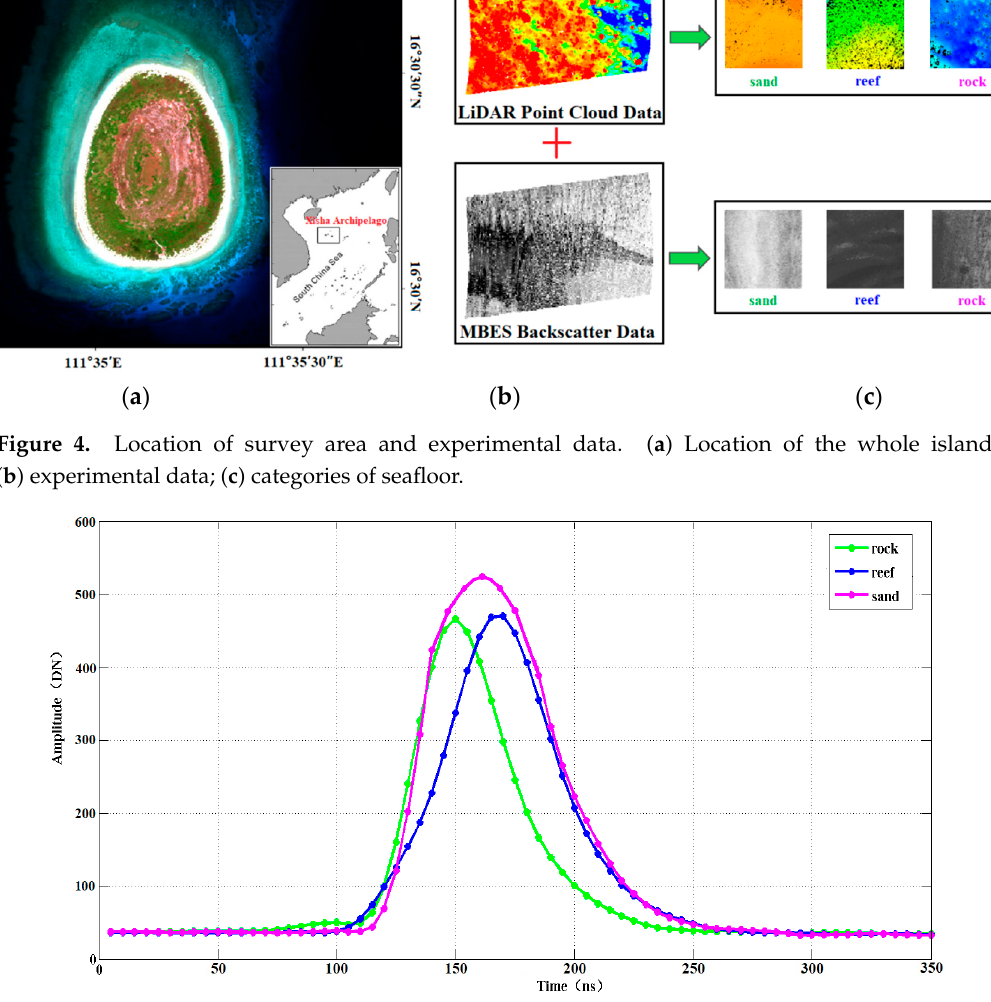
Figure 5. Different waveforms of the seafloor at the same time. Magenta waveform represents sand, blue waveform represents reef, and green waveform represents rock.